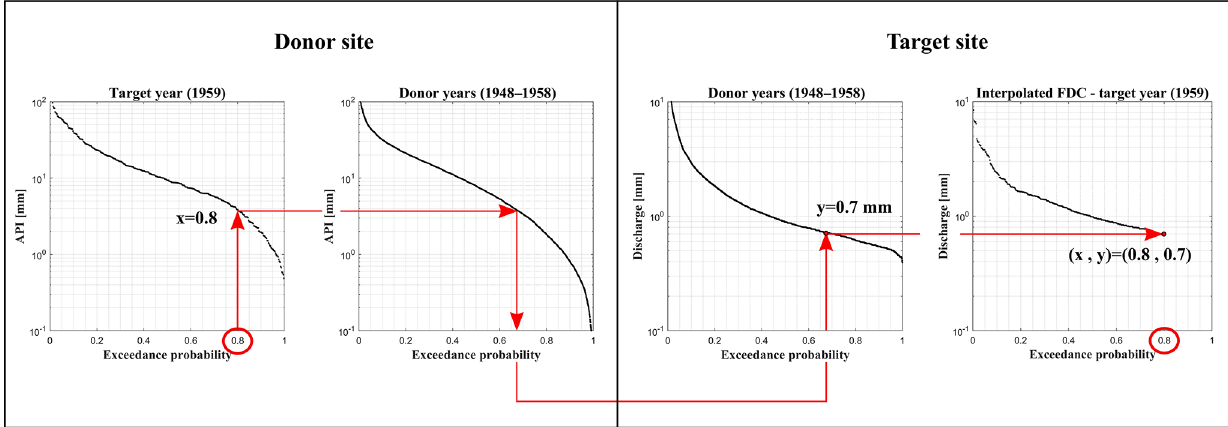
Figure 6. Illustration of FDC generation using the interpolation with the API of the donor site as a